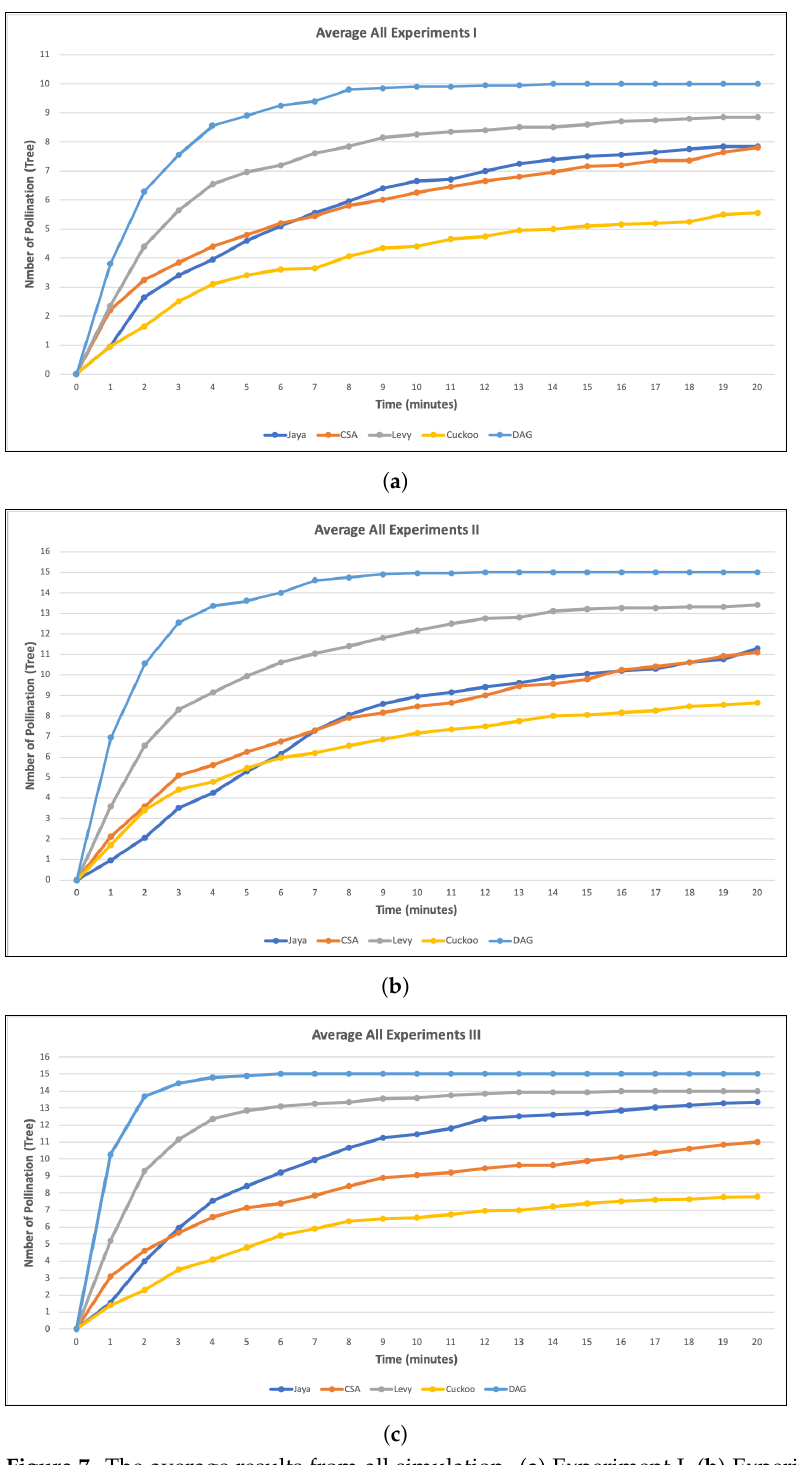
Figure 7. The average results from all simulation. ( a ) Experiment I. ( b ) Experiment II. ( c ) Experi- ment